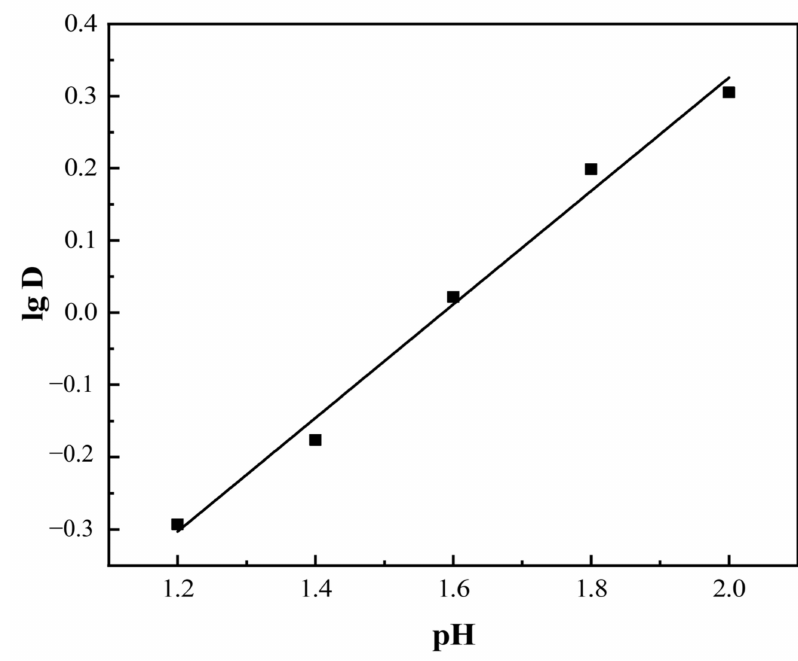
Figure 8. The relationship between the lg D of Y 3+ and the equilibrium pH. The influence of the concentration of P204 on the extraction ratio of Y 3+ using the simulated solution with the Y 3+ concentration of 0.01 M was investigated. The relationship between lg D and lg[H 2 A 2 ] was drawn. It can be seen from Figure 9 that the slope is about 1, i.e., m equals 1, which demonstrates that each time a Y 3+ is extracted, there will be an H 2 A 2 involved in the